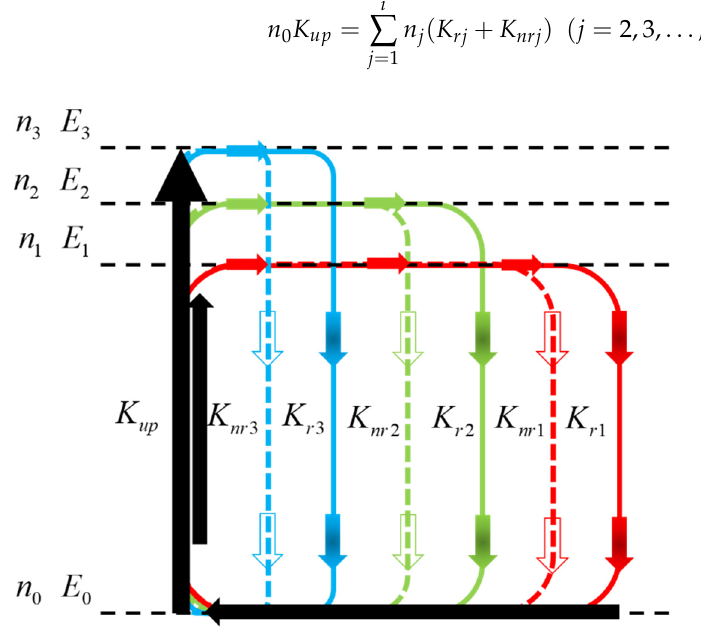
Figure 4. The model of temperature-dependent PL emission. See the text for the meaning of the symbols.